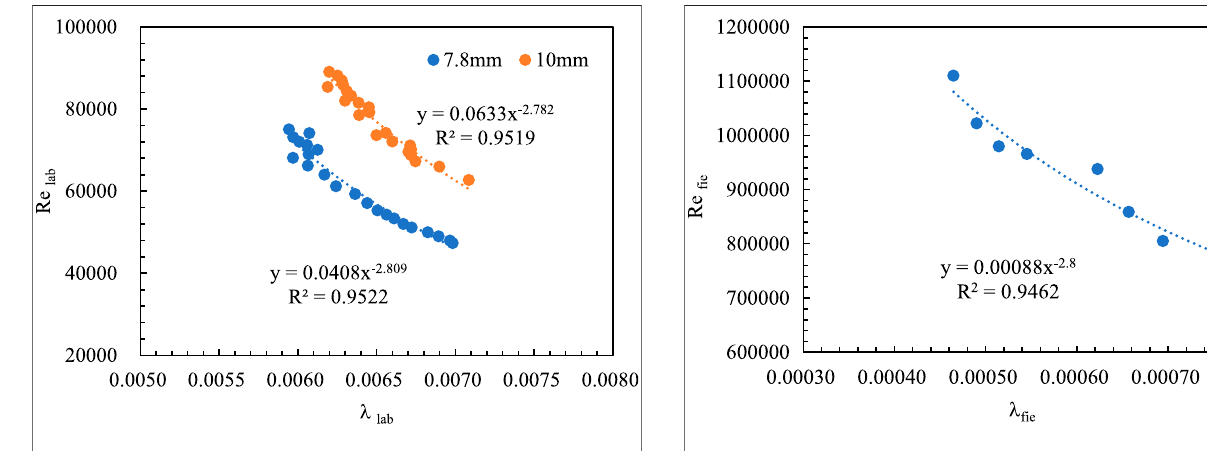
FIGURE 3 | Changes in Re fi e with λ fi e of